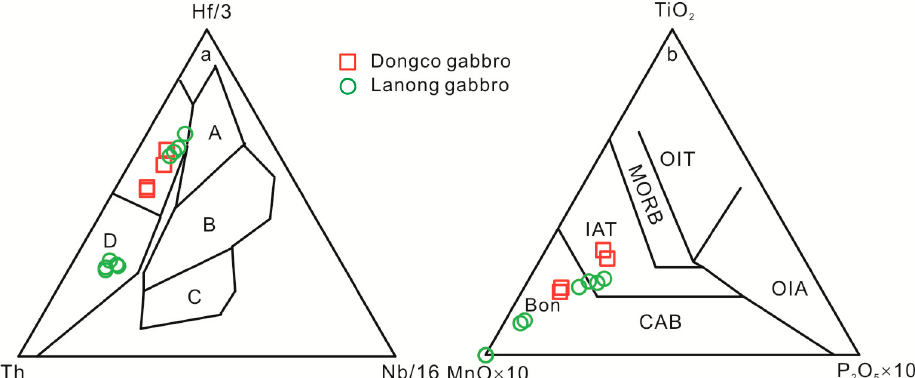
Figure 9. Ternary tectonic discrimination plots for the investigated non-cumulative gabbros from the Dongco and Lanong ophiolites. ( a ) Th–Nb–Hf diagram [50]; A: N-MORB, B: E-MORB, C: Within-plate alkali basalt (WPA), D: Island arc tholeiite basalt (IAT). ( b ) MnO–TiO 2 –P 2 O 5 [58]; OIT: Ocean island tholeiite or seamount tholeiite; OIA: Ocean island alkali basalt or seamount alkali basalt; CAB: Island arc calc-alkaline basalt; IAT: Island arc tholeiite; Bon: boninite.